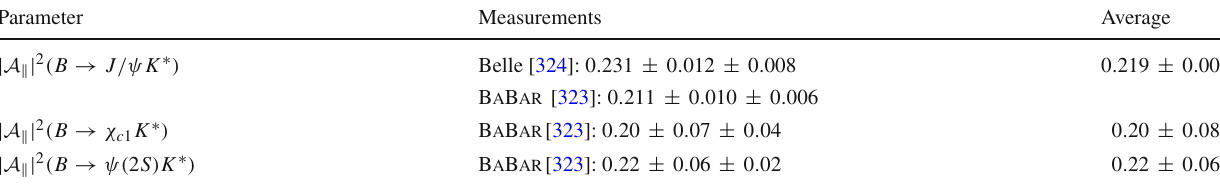
Table 180 Decay amplitudes for parallel transverse polarization